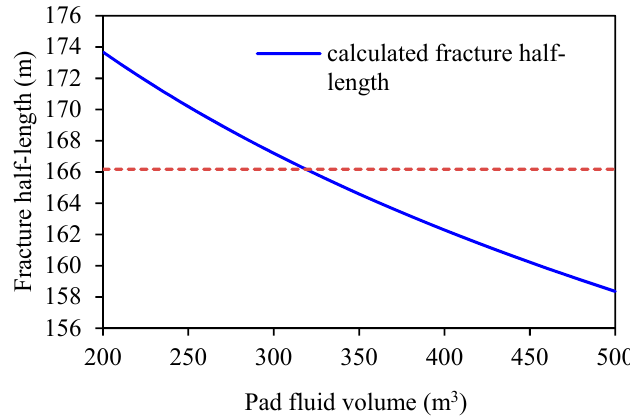
Figure 8. Curves of propped fracture half-length vs. pad fluid volume for the second adjusted design.